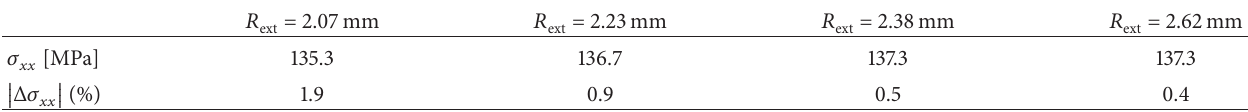
Table 1: Values of the measured average stress obtained by keeping constant 𝑅 int = 1.59 mm and by changing 𝑅 value was 𝜎 𝑥𝑥 = 138 MPa. Also standard deviations are reported as a result of three different drilled holes.